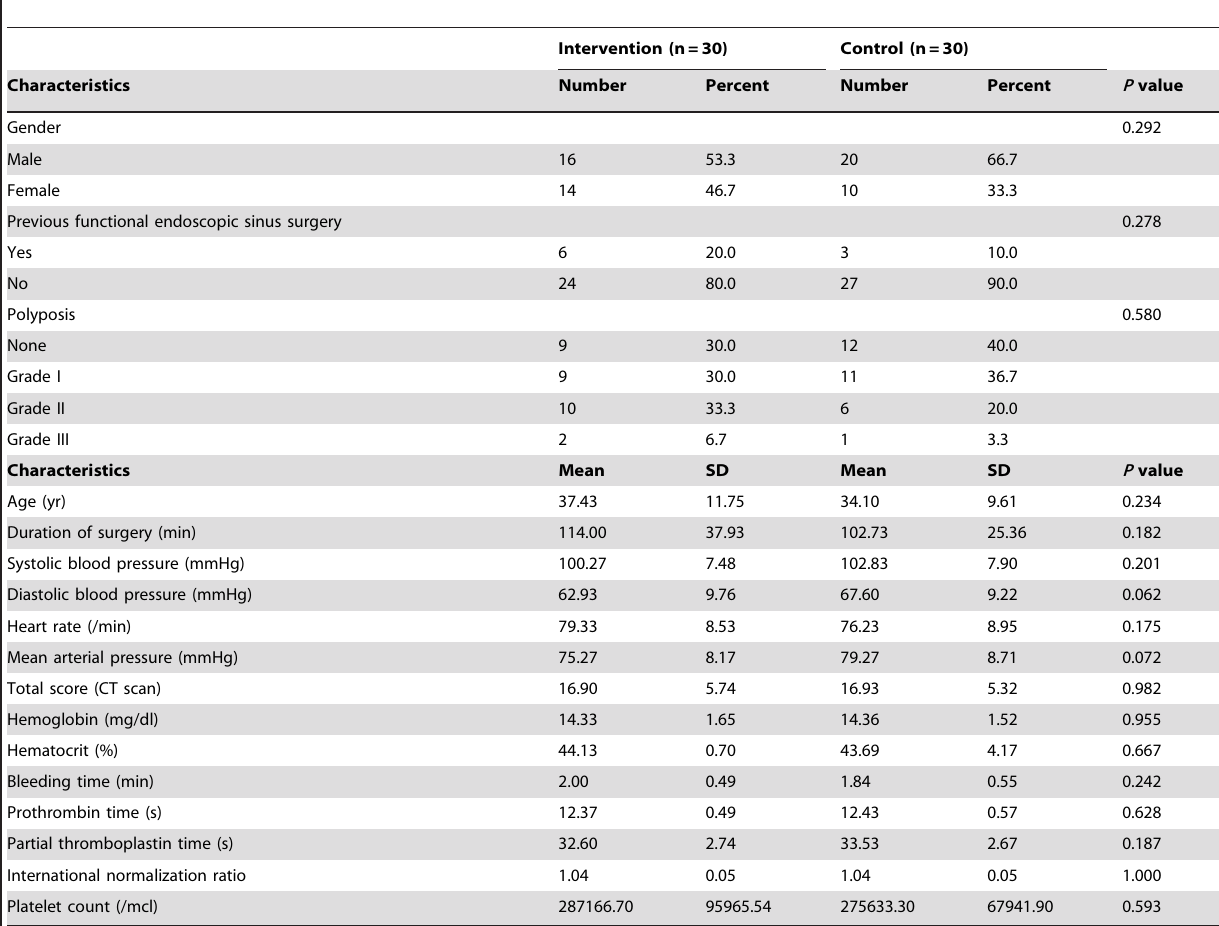
Table 2. Distribution of the characteristics of the study population by groups, intervention (tranexamic acid plus phenylephrine) versus control (phenylephrine